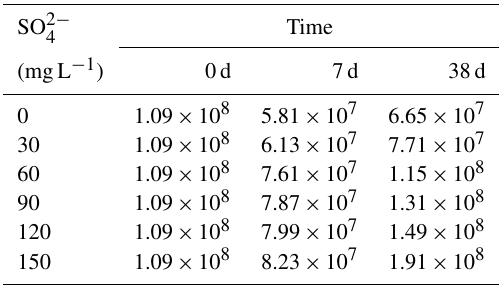
Table 2. Copy numbers of the dsrB gene of SRB in the sediments during the incubation (copiesg − 1